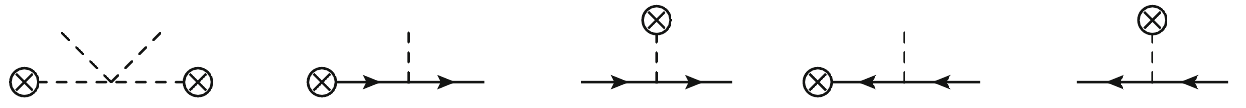
Fig. 18 Various vertices containing two internal matter legs (scalar–scalar, scalar–fermion, fermion–fermion). Here the dashed line is the scalar while the solid line with arrow is the fermion. The lines ending with a circle containing a cross are external